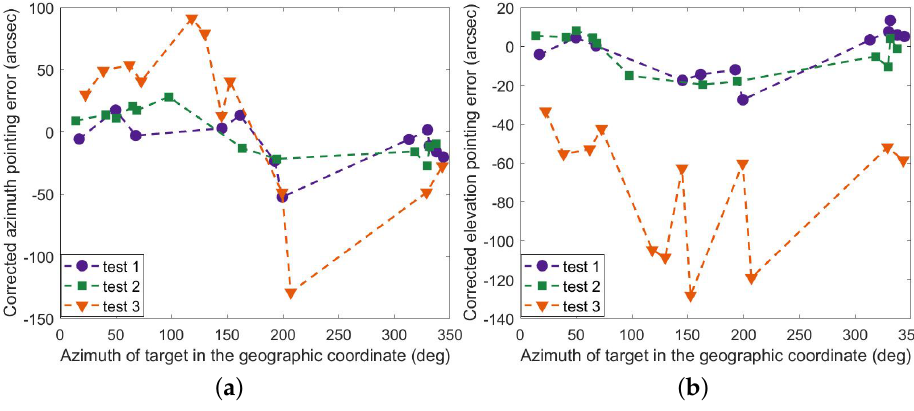
Figure 12. Residual errors of FPM ( a ) in azimuth and ( b ) in elevation.